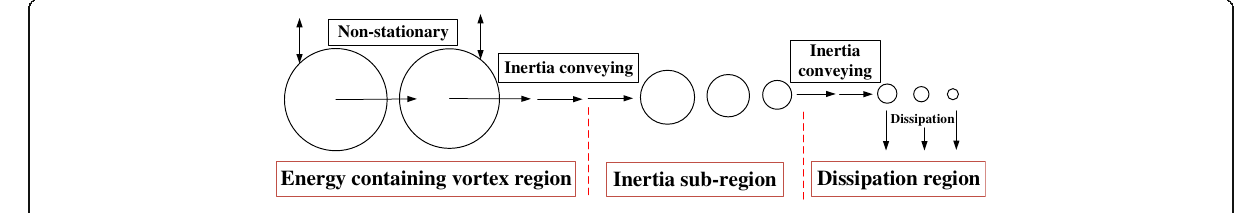
Fig. 9 Cascade transport mechanism of turbulence flow energy [39, 40]